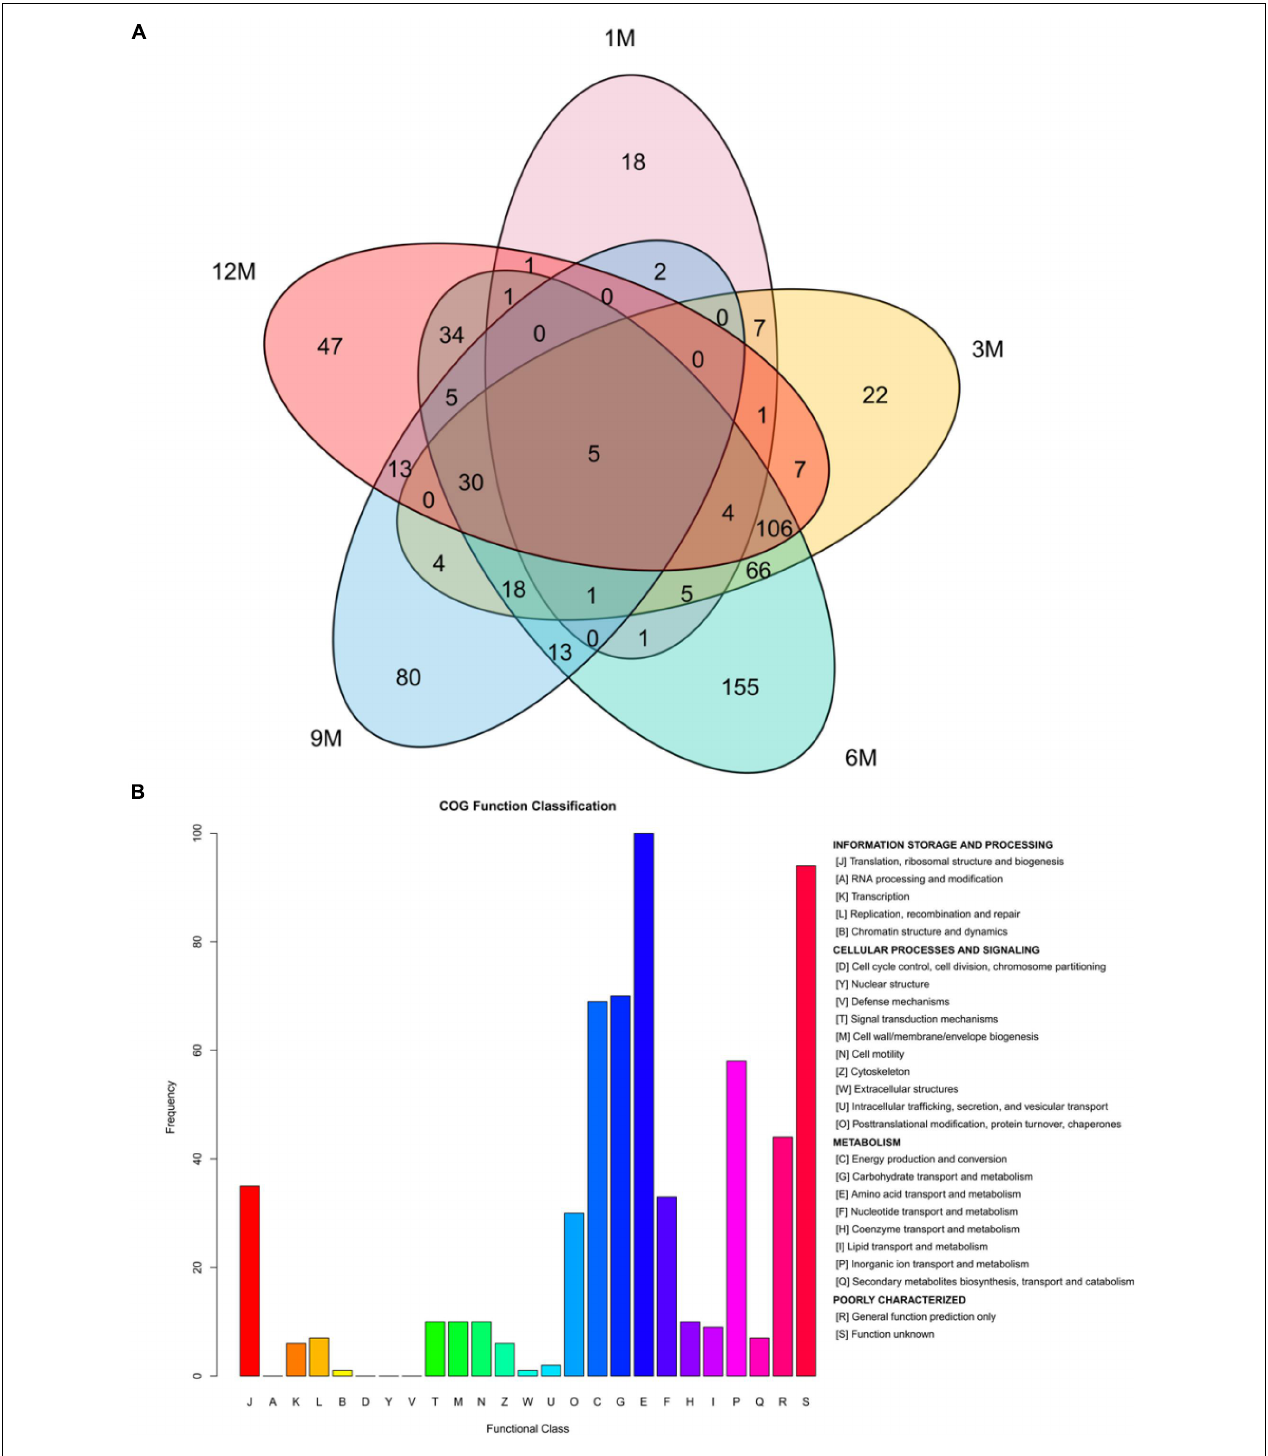
FIGURE 2 | Venn plot analysis (A) and homologous classification (B) of proteins identified during the fermentation of traditional fish sauces.